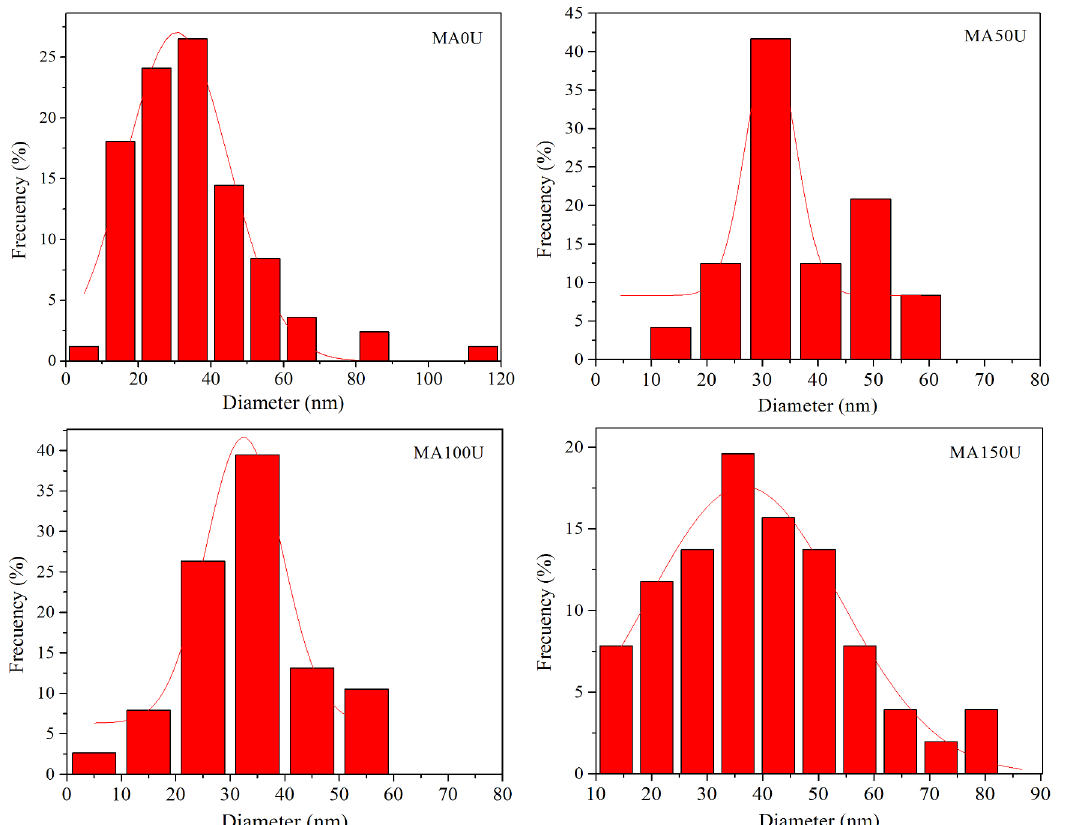
Figure 7. Crystallite size distribution of the samples prepared from the use of distinct masses of urea during the microwave assisted